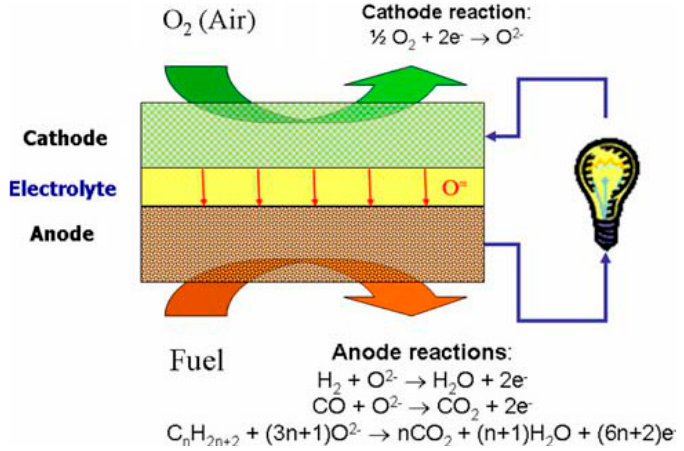
Figure 1. Schematic diagram of a solid oxide fuel cell (SOFC). (Reprinted with permission from [3], 2008, Springer Science+Business Media,